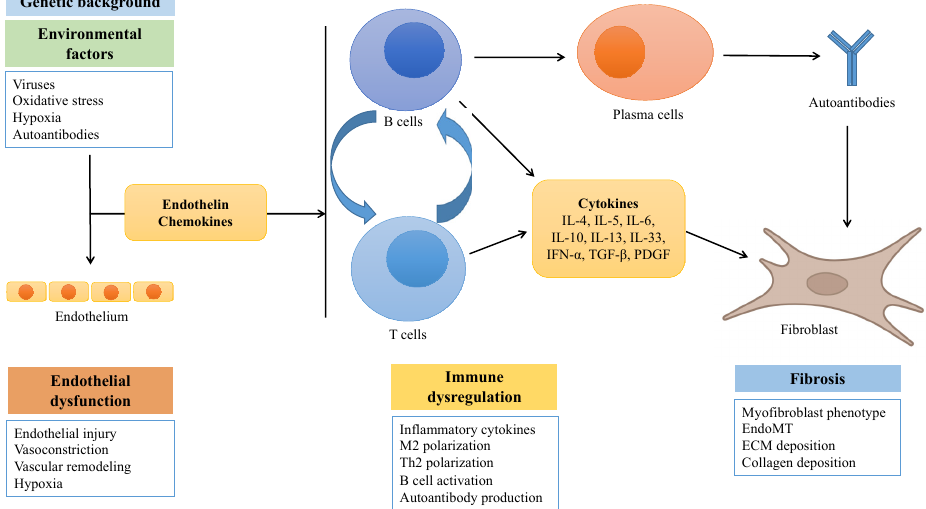
Figure 1. Simplified scheme showing the main processes involved in the pathogenesis of systemic sclerosis.